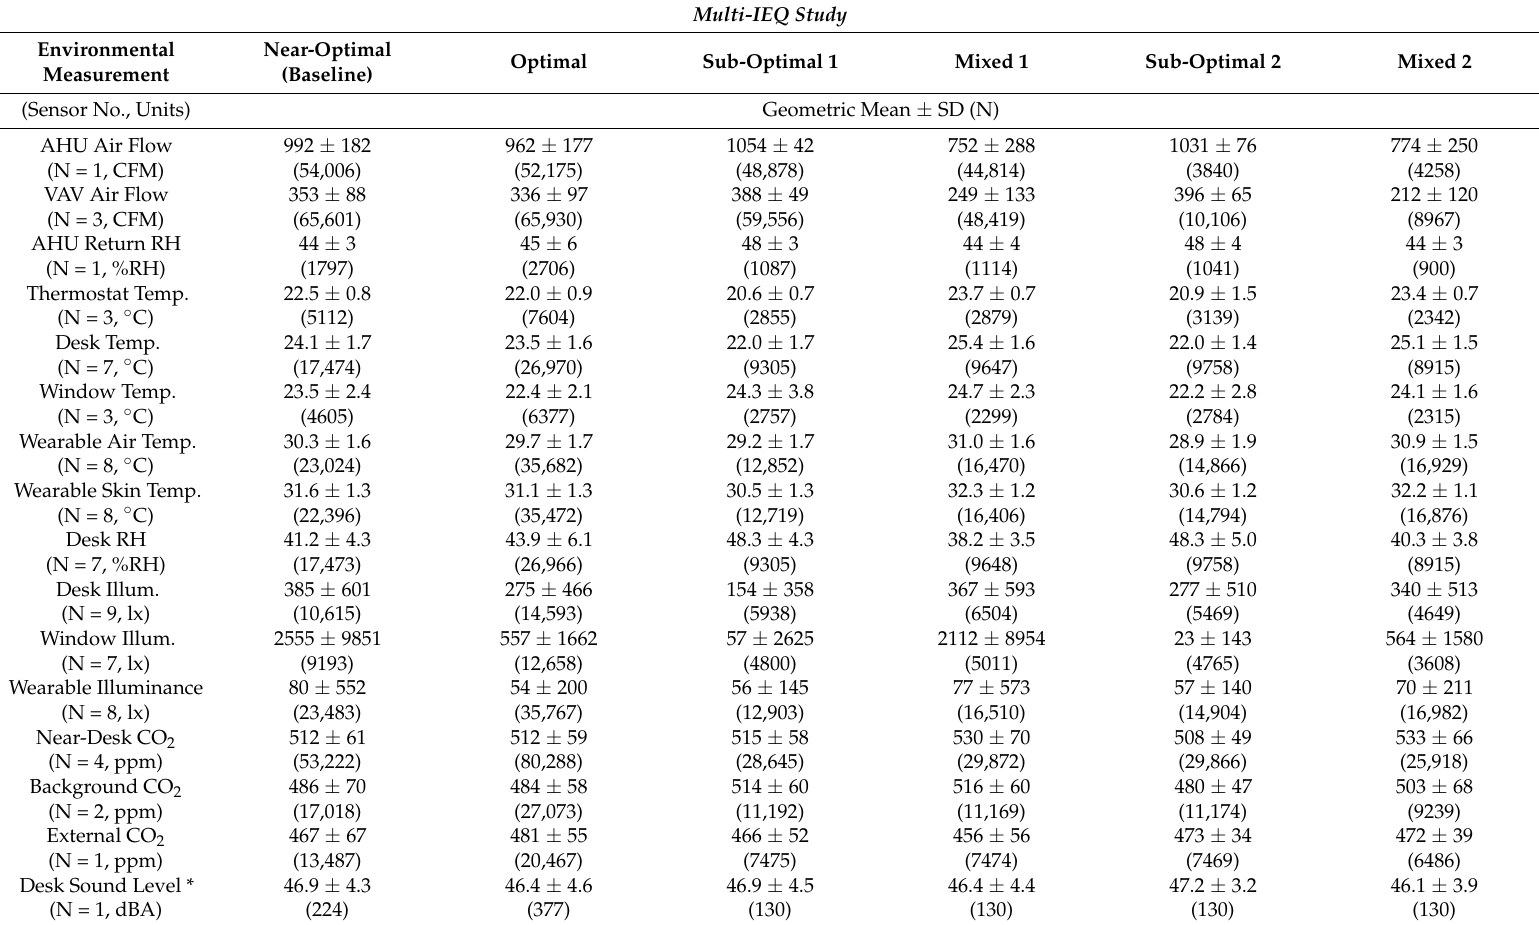
Table 3. Geometric mean ( ± SD) of environmental conditions and observation numbers (N) measured by sensor networks and building systems during work hours (06:00–18:00) during the multi-IEQ study.